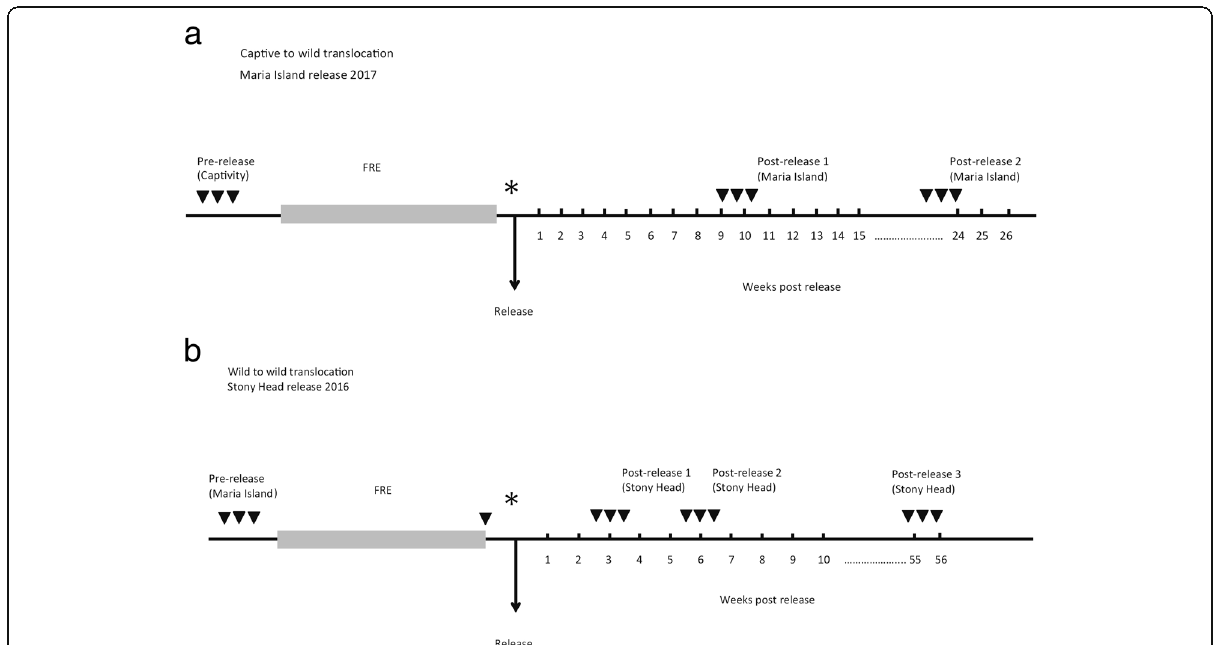
Fig. 1 Timeline of the two translocation events. a Captive-to-wild translocation (Maria Island release 2017). A total of 8 female devils from the captive insurance population were released. Devils were kept in a free-range enclosure (FRE) for approximately 6 weeks prior to the release. b Wild-to-wild translocation (Stony Head release 2016). Seventeen wild devils originating from Maria Island were translocated to Stony Head. Release devils were housed in a free-range enclosure (FRE) for 12 weeks prior to the release. All faecal samples were collected opportunistically at various time points throughout the translocation processes. Arrows represent time points at which faecal samples were